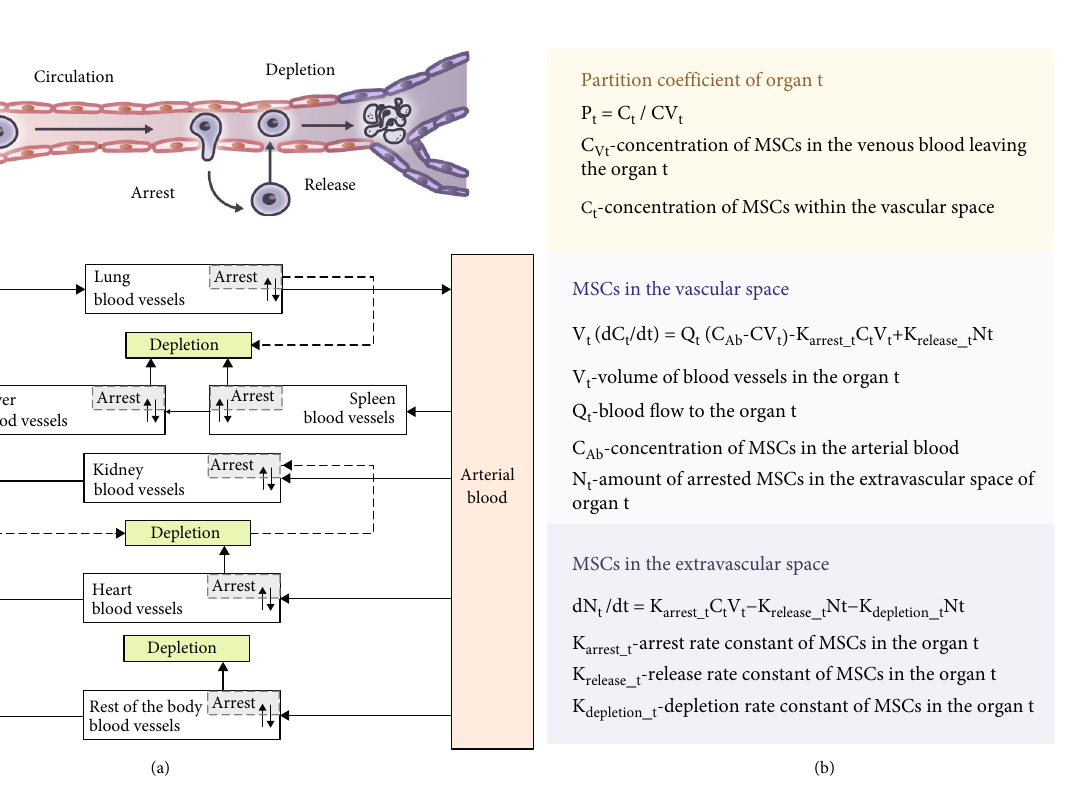
Figure 3: Structures and the mathematical equations of the available PK model of MSCs. (a) Schematic diagram of the PK model for the administered MSCs in vivo . Solid arrows indicate the blood fl ow, dashed grey arrows indicate the depletion of MSCs, and grey boxes indicate the arrested MSCs isolated from blood circulation as in the extravascular space of the organ. (b) The equations to calculate MSC concentration in the respective organs